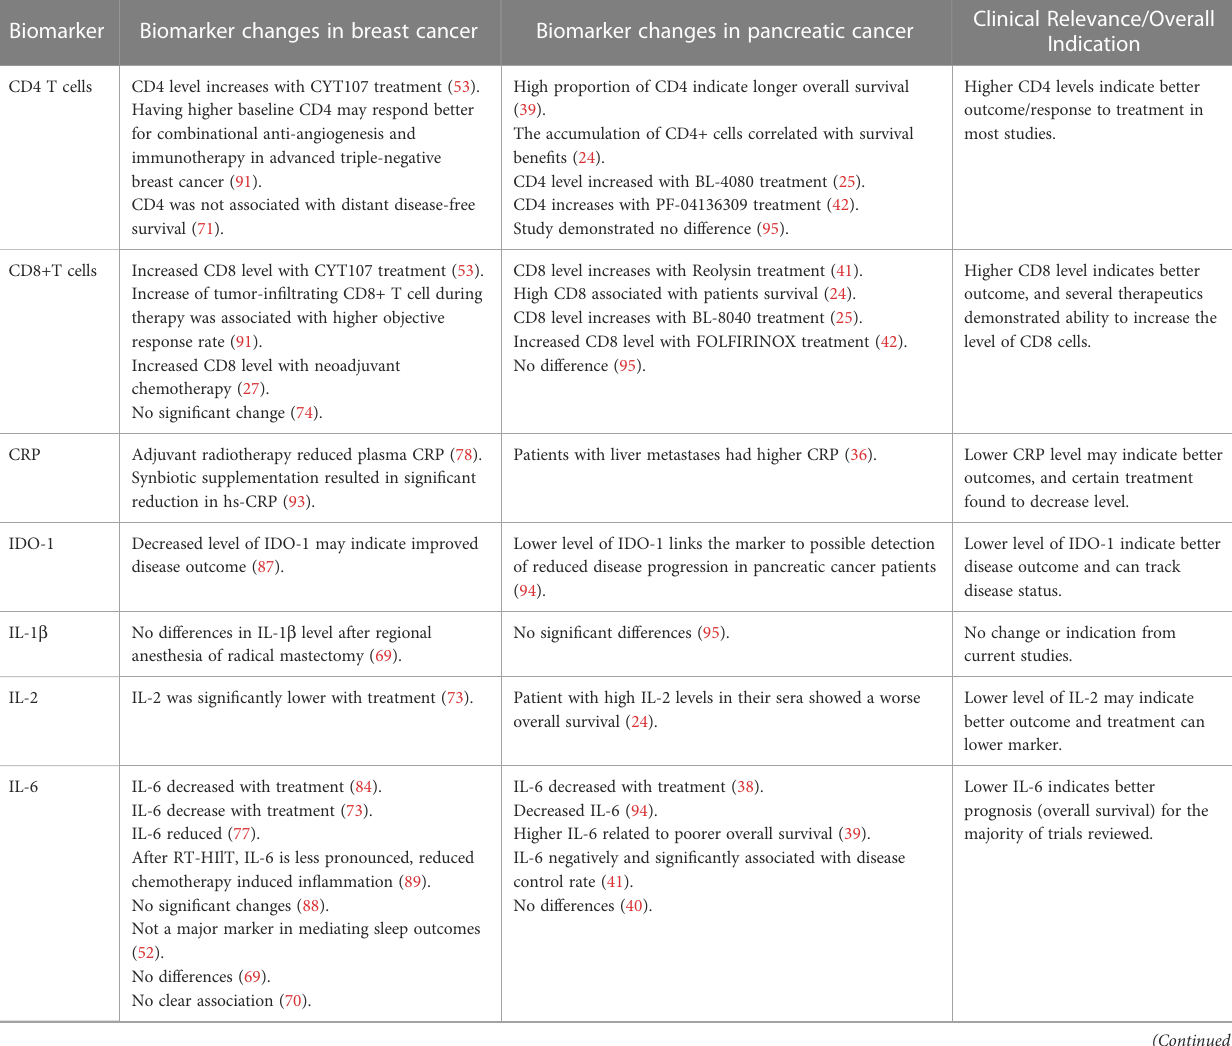
TABLE 5 Trial-de fi ned in fl ammatory biomarker changes with clinical utility in both breast cancer and pancreatic cancer.